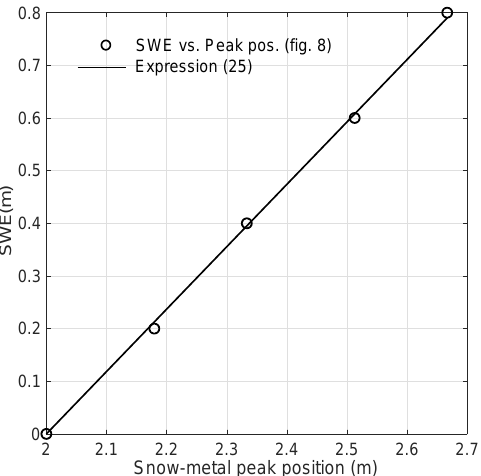
Figure 9. Comparison between the SWE and the displacement of the metal reflectance for the structure of Figure 7 by matrix simulation (circles) and the analytical expression 25 (solid line) assuming linearity of the real part of refractive index vs. the density.